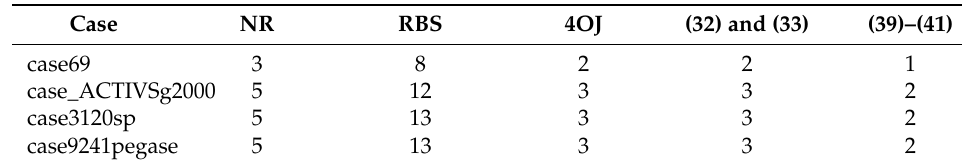
Table 1. Total iterations for well-conditioned cases.